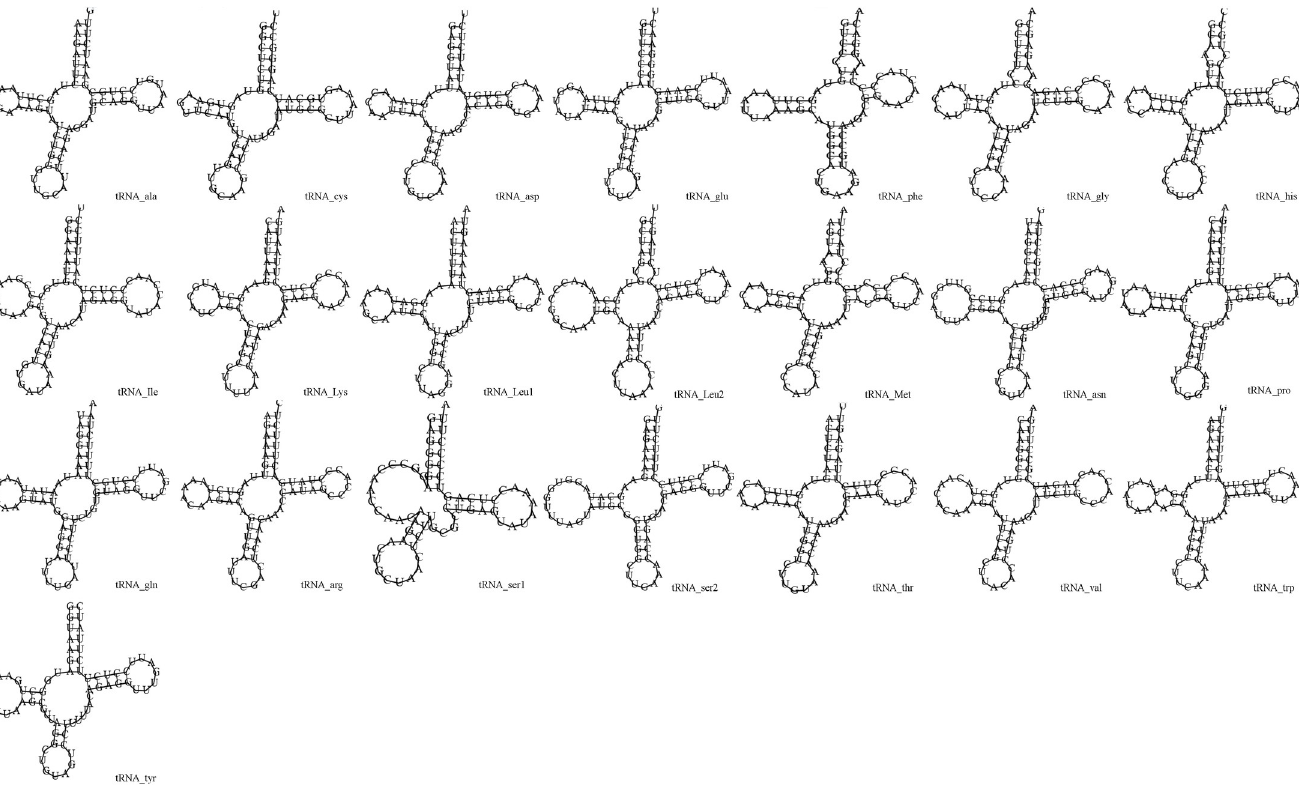
PLOS ONE | https://doi.org/10.1371/journal.pone.0241098 April 9,